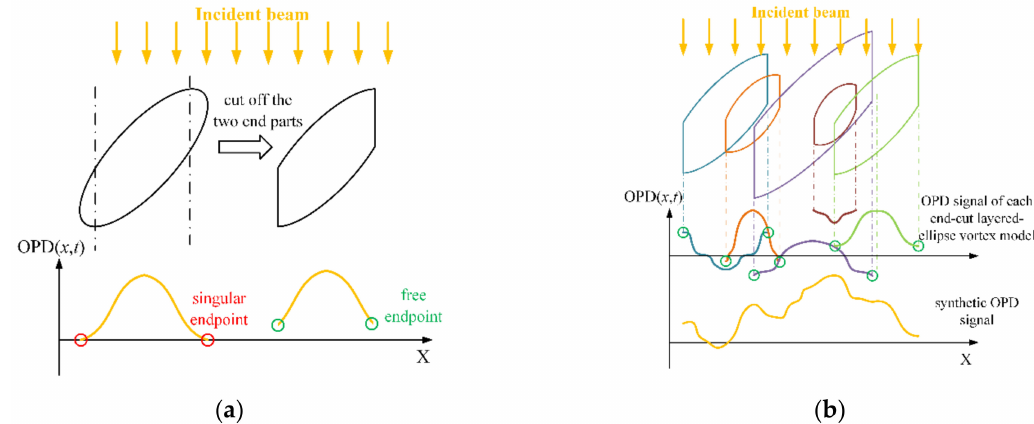
Figure 6. The end-cut layered-ellipse vortex model: ( a ) We cut off the two end parts of the layered-ellipse vortex model; ( b ) the OPD signal produced by the density field at a certain wall height layer is decomposed to the OPDs of multiple concatenated end-cut layered-ellipse vortex models (The colors of end-cut layered-ellipse show that they cause different OPDs. The bottom OPD signal plotted by the yellow curve is the synthesis of the OPDs with different colors above